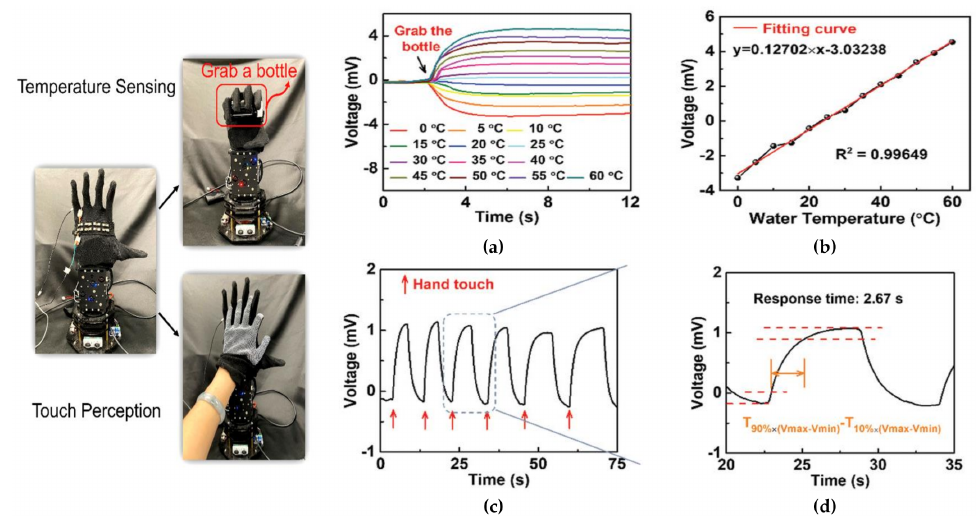
Figure 11. Applications of e-skin based on uf-TEG for temperature measurement and touch detection. Performance for 8-pair uf-TEGs in measuring temperature ( a ). V OUT –T WATER characteristic and fitting curve ( b ). Using uf-TEGs for touch perception test ( c ) and response time ( d )